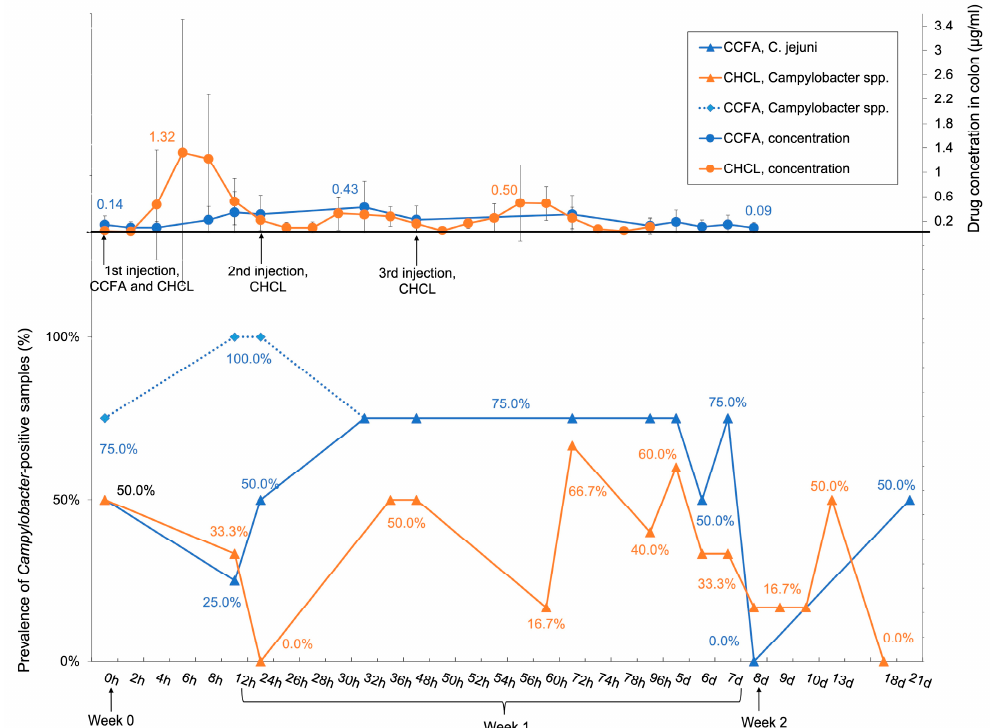
Figure 3. Drug concentrations in the colon and prevalence of Campylobacter -positive samples from the CCFA and CHCL groups. Upper panel , concentrations of CCFA (blue) and CHCL (orange). These drug concentration data were also presented earlier [17]. Lower panel , prevalence of Campylobacter spp. in CCFA (blue dashed lines) and CHCL (solid orange lines). Solid blue lines indicate prevalence of C. jejuni in the CCFA samples. C. jejuni prevalence in CHCL is not shown, as it was almost identical to total Campylobacter spp. Prevalence data are based on CCFA and CHCL samples processed at 37 °C. The concentrations of the drugs in the colon and prevalence of Campylobacter spp. and C. jejuni were determined as described in Materials and Methods.